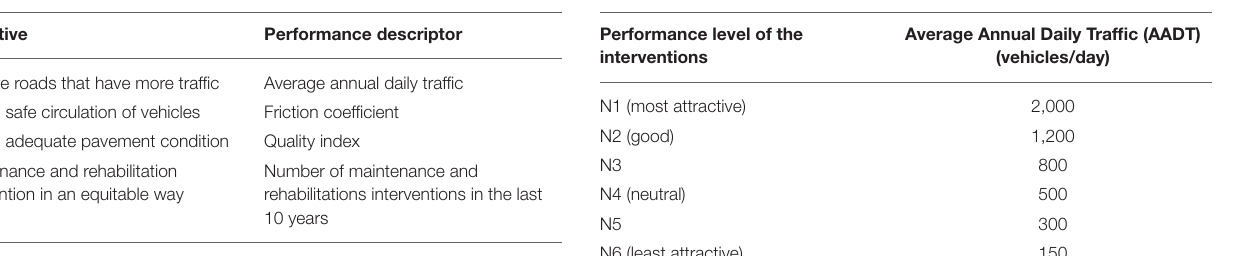
TABLE 1 | Objectives and performance descriptors. TABLE 2 | Performance scale of the interventions relative to